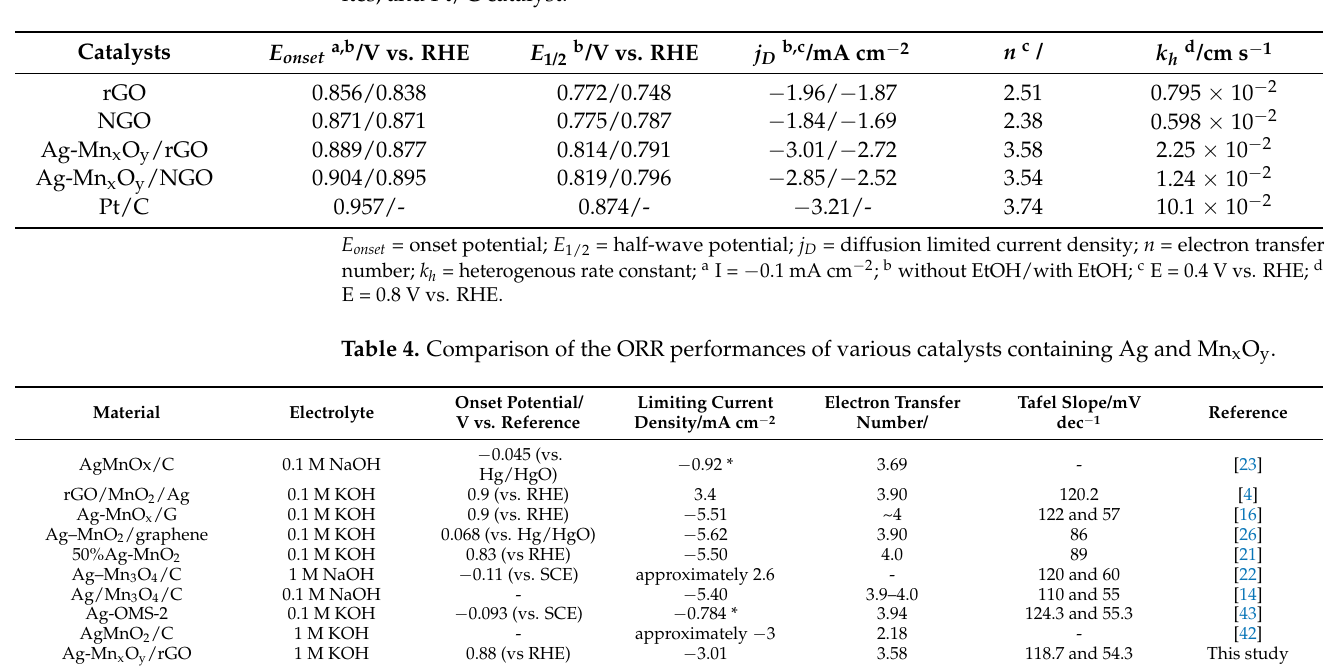
Table 3. Electrochemical characterization results of the graphene derivatives, Ag-Mn x O y /C compos- ites, and Pt/C catalyst.